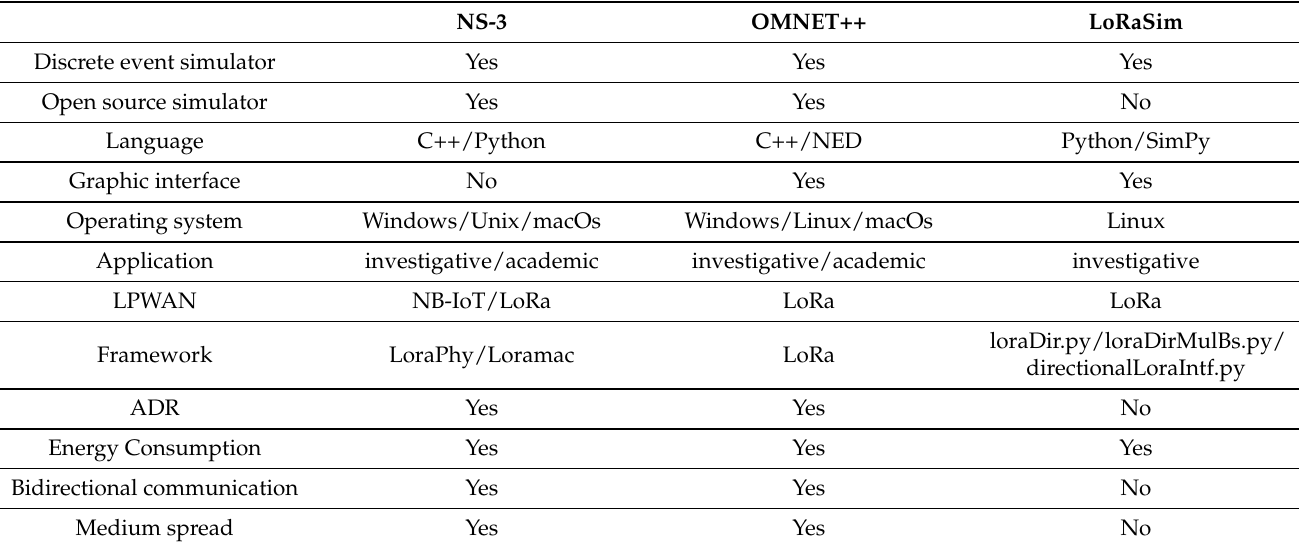
Table 4. Comparison of simulators. Adapted from [64] and completed with new data by authors